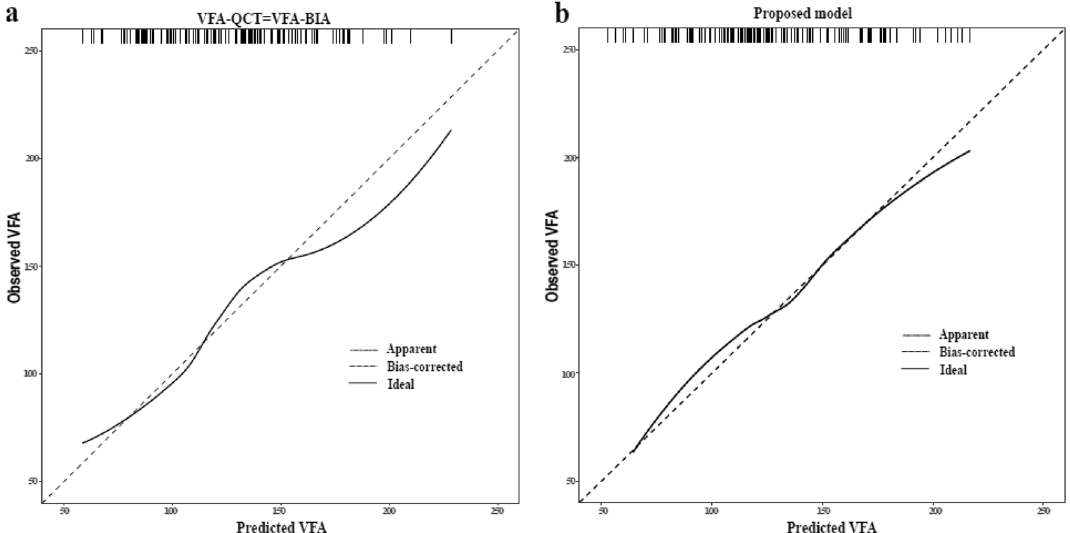
Figure 2. Calibration plots of prediction model in female. ( a ) A univariate regression analysis of predicted VFA by VFA-BIA (MSE = 1085.9). ( b ) A multivariate regression analysis of predicted VFA with VFA-BIA, age, BMI, and WC (MSE = 806.1).